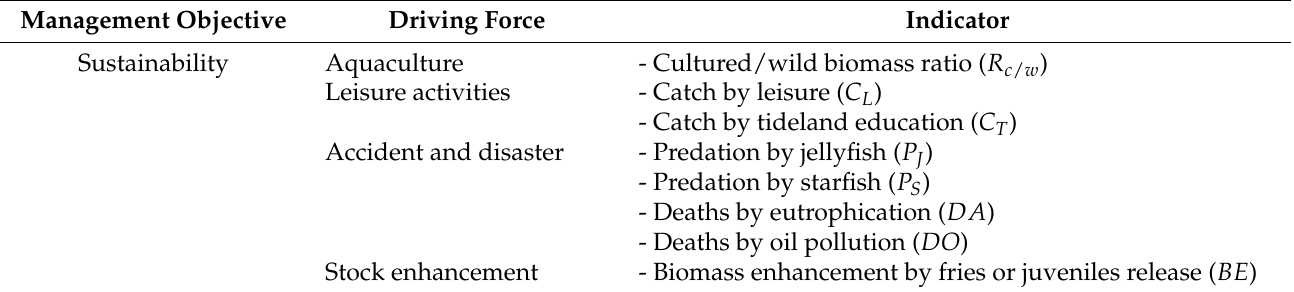
Table A2. Indicators for other driving forces in the extended